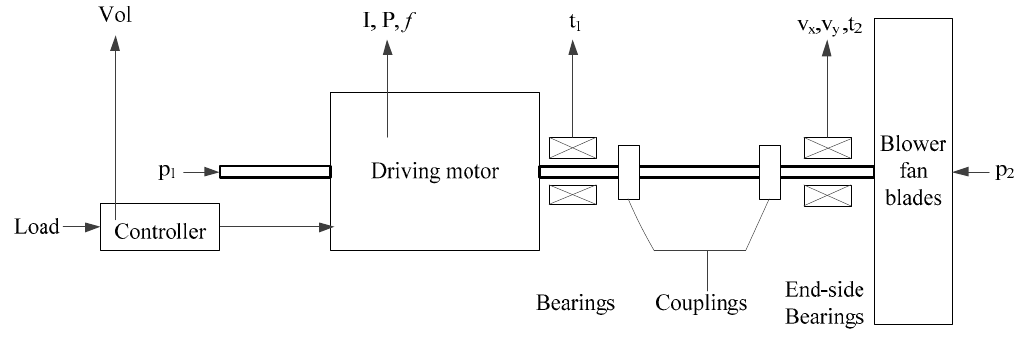
Figure 1. Layout of the blower fan.